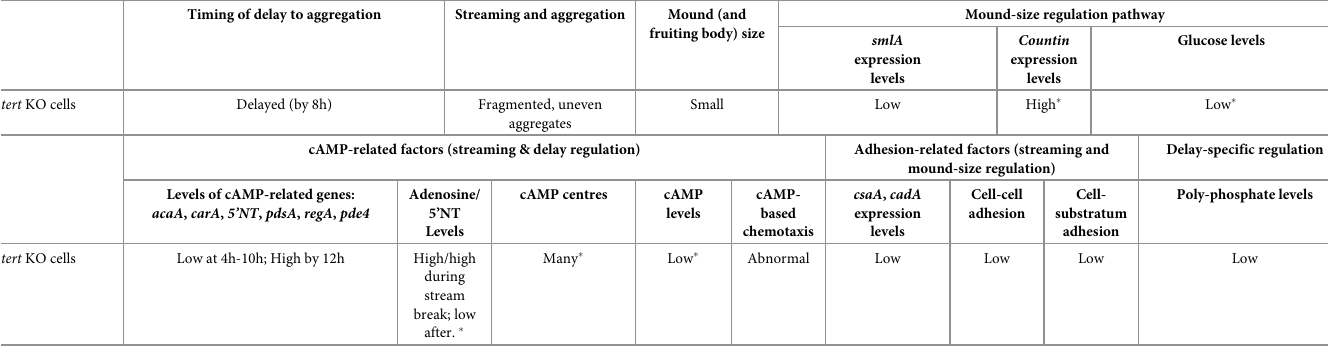
Table 1. Phenotypic differences between wild-type and tert KO development of D . discoideum , and some possible causal factors.